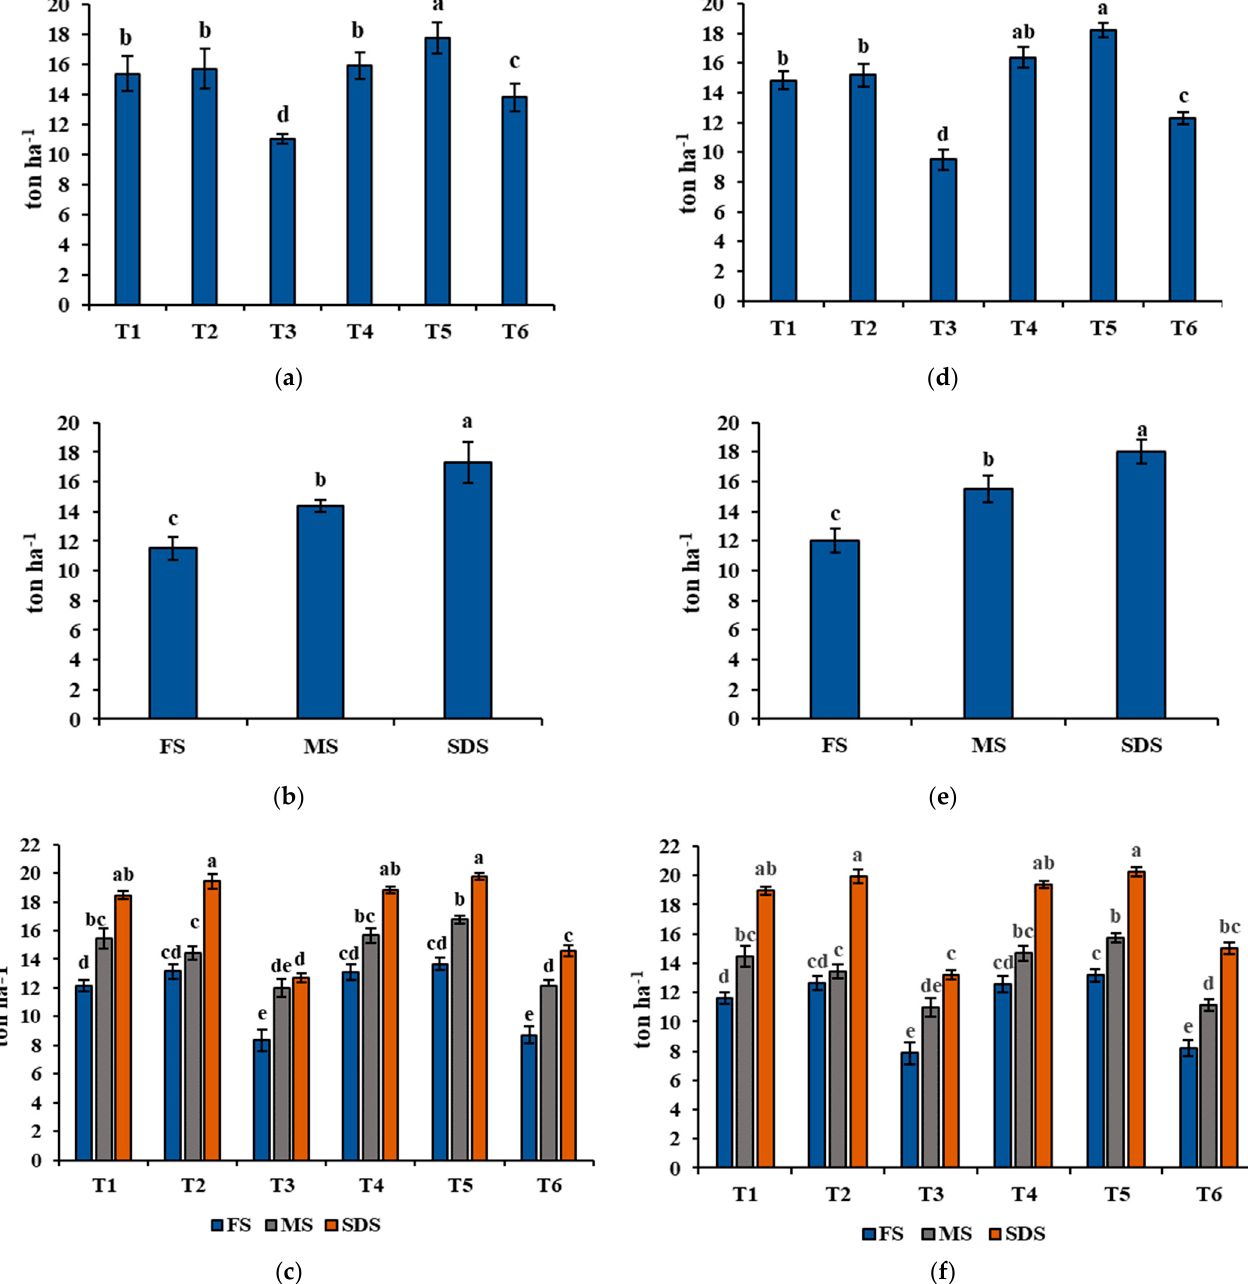
Figure 4. Agronomic parameter, dry matter yield (DMY) recorded during the 2020 and 2021 growing seasons. Explanations: ( a ) treatment (year 2020); ( b ) harvesting times (year 2020); ( c ) interaction between treatment and harvesting times (year 2020); ( d ) treatment (year 2021); ( e ) harvesting time (year 2021); ( f ) interaction between treatment and harvesting times (year 2021). The treatments are indicated as follows: T1 = wheat cultivar 1 (Xiaoyan 17) sole cropping; T2 = wheat cultivar 2 (Baomai 9) sole cropping; T3 = ryegrass sole cropping; T4 = wheat cultivar 1 (Xiaoyan 17) with alfalfa mixed cropping; T5 = wheat cultivar 2 (Baomai 9) with alfalfa mixed cropping; T6 = ryegrass with alfalfa mixed cropping, and the cutting time is indicated as FS = harvested at flowering stage of cereal (wheat); MS = harvested at milk stage of cereal (wheat); SDS = harvested at soft dough stage of cereal (wheat). Different letters express significant differences at p < 0.05. Standard deviation specified by bars.